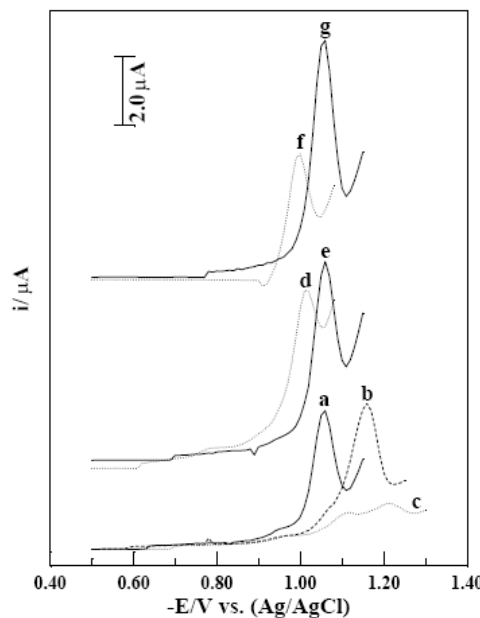
Fig. 3 SW-AdCS voltammograms for 2 × 10 − 7 M bulk tolmetin in a B-R buffer of pH: 2 (a), 3 (b) & 4 (c), a hydrochloric acid solution of pH : 1 (d) & 2 (e) and a perchloric acid solution of pH : 1 (f) & 2 (g); E acc = − 0 . 5 V, t acc = 30 s; f = 120 Hz, Δ s = 10 mV and E sw = 25